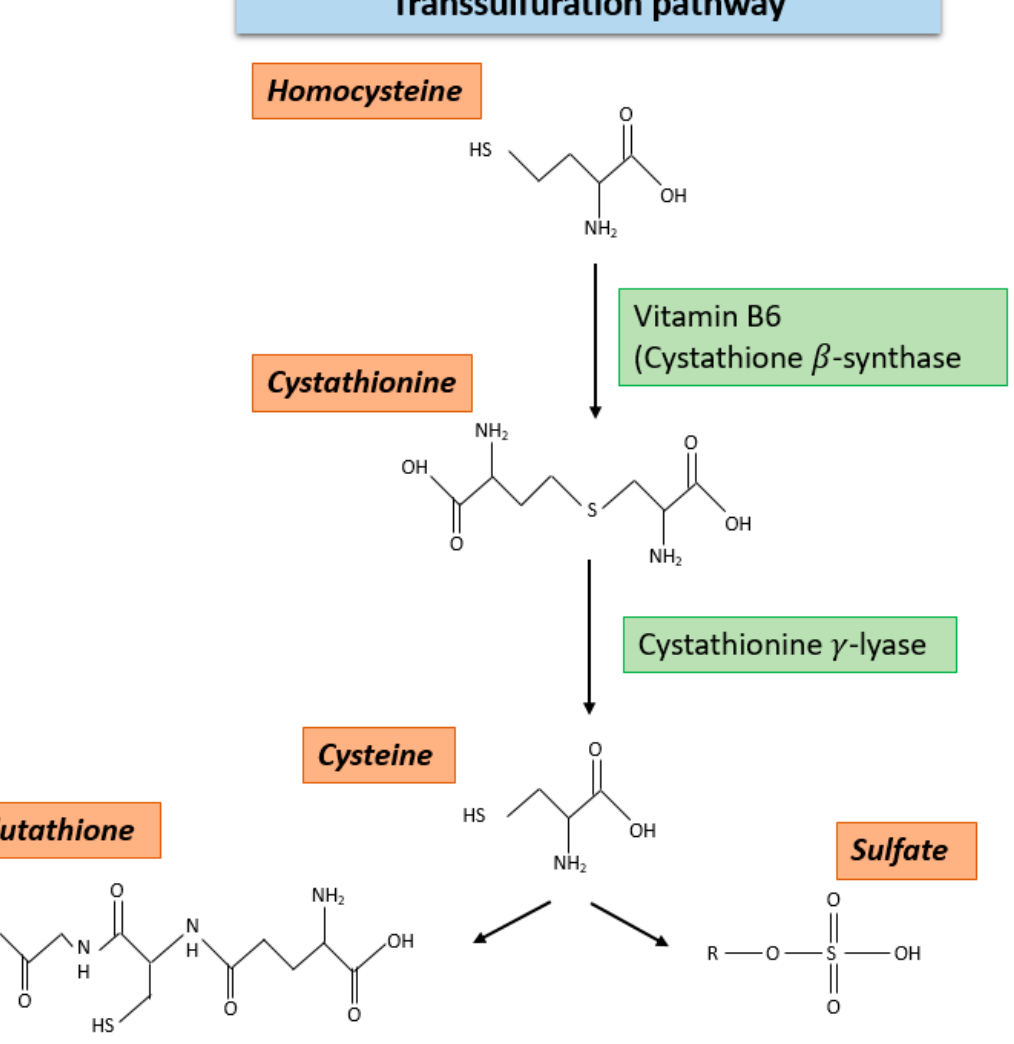
Figure 3. The transsulfuration pathway.